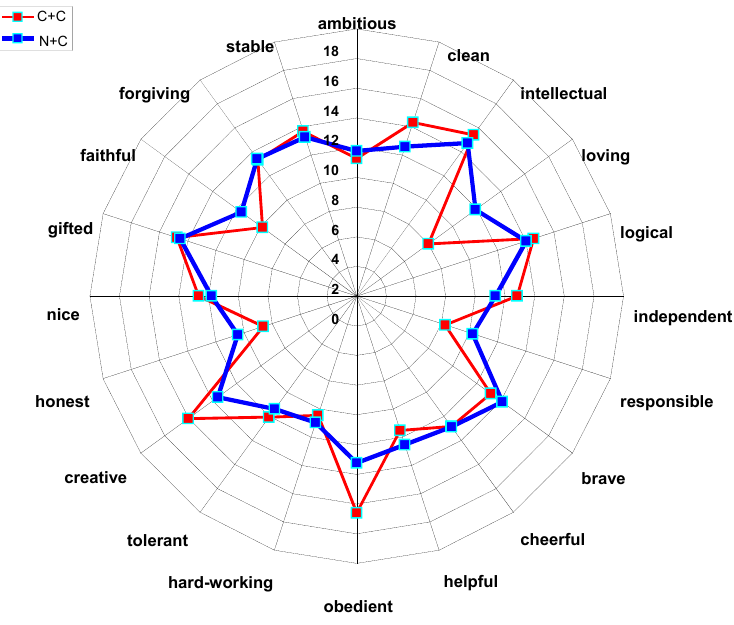
Figure 5. Statement of the terminal value preferences of Catholic respondents and respondents not declaring religion from Catholic families. Source: own study based on research results.